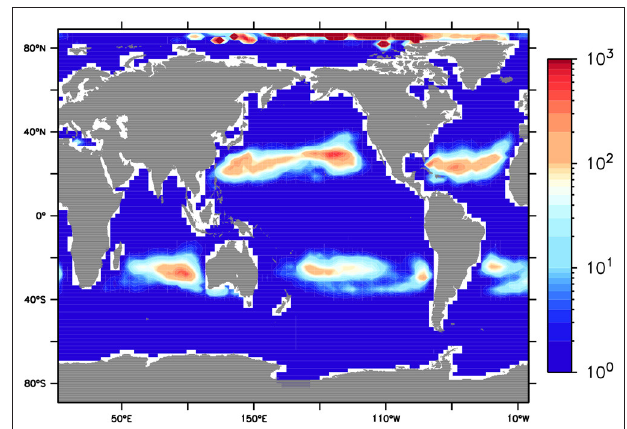
FIGURE 4 | Number of days from year 2010 it took for marine aggregate export at the seafloor to deposit an amount of MP equivalent to the surface concentration, if it is assumed 1 MP particle is transported by 1 organic